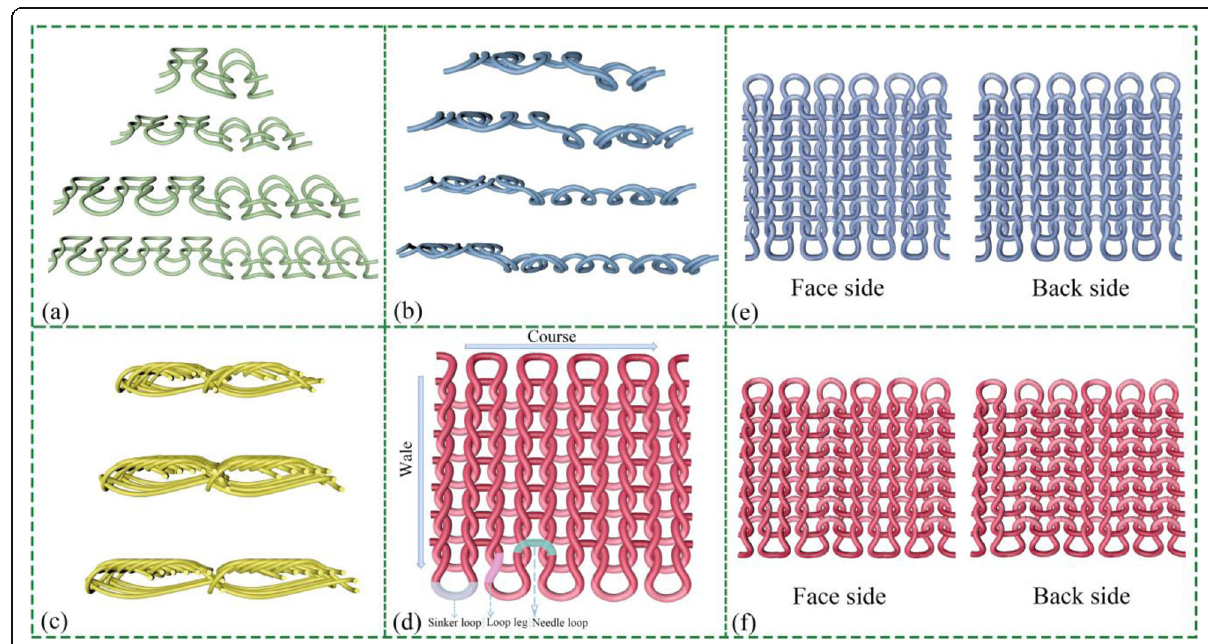
Fig. 3 Schematic characteristics and components of knit structures. a Characteristics of m*n rib. b Characteristics of 2*m rib. c Characteristics of some needle horizontal cord. d Knitting-technique nomenclature. e Image of the face side and back side in the 1*1 rib structure. f Image of the face side and back side in 2* 1 rib structure